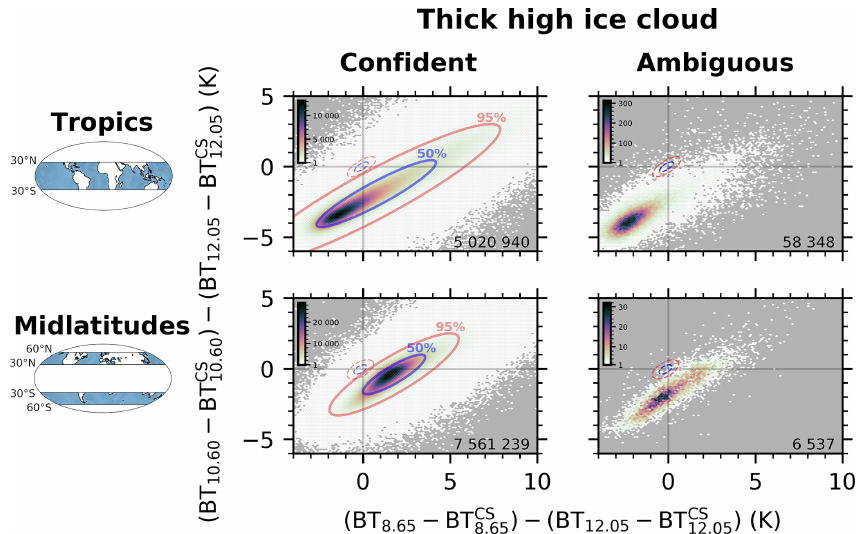
Figure B2. As Fig. B1 for thick ice cloud monolayer observations in the upper troposphere ( τ > 3 and z top > 8km).